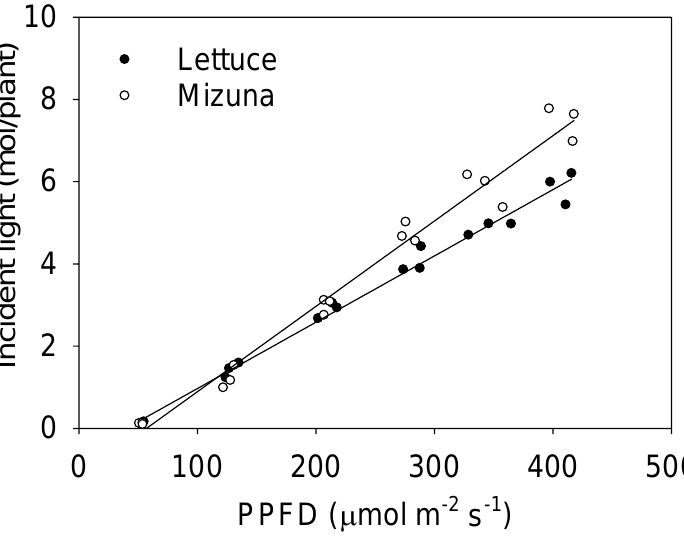
Figure 3. The total incident light on the plant canopy throughout the growing period of mizuna ( Brassica rapa var. japonica ) and lettuce ( Lactuca sativa ‘Green Salad Bowl’) plants grown at six different photosynthetic photon flux densities (PPFDs) for 27 and 28 days, respectively. Lines show the results from multiple regression analysis ( R 2 = 0.98), which indicated a significant species × PPFD interaction ( P < 0.0001). Each data point represents the mean of nine plants.